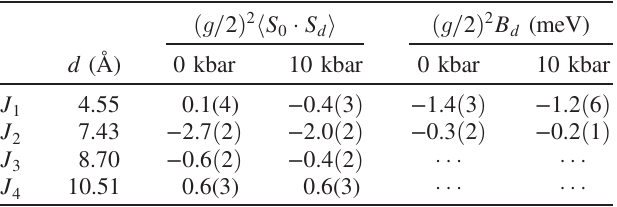
TABLE II. Exchange interactions and spin-spin correlations for distinct spin pairs in FeSc 2 S 4 extracted from fits to experimental data. Bonds are labeled according to Figs. 5(b) and 5(c). Magnetic interactions labeled J and J 0 cannot be distinguished i i and so are represented by their average. The factors ð g= 2 Þ 2 hð S Þ 2 i ¼ 3 . 3 ð 3 Þ and ð g= 2 Þ 2 D ¼ 5 . 0 ð 8 Þ meV are also 0 extracted from these fits at both 0 and 10